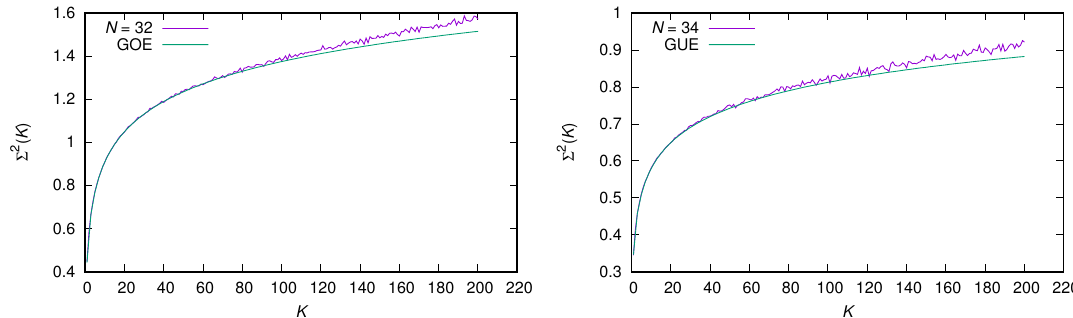
Figure 24 . (cid:6) 2 ( K ) for the SYK model, N = 32 (250 samples) and N = 34 (110 samples), obtained using the unfolded spectra after shifting and rescaling. The curves for corresponding random matrix ensembles, GOE and GUE, are also